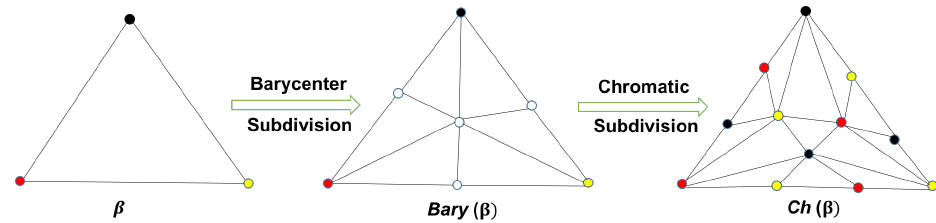
Figure 2. Once barycenter subdivision and once standard chromatic subdivision of a 2-simplex β